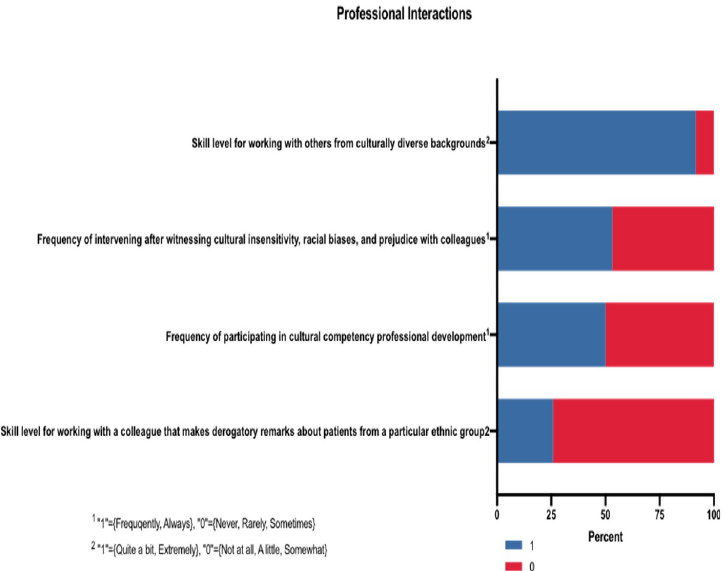
Fig 3. Professional interactions results. 1 “1” = {Frequently, Always}, “0” = {Never, Rarely, Sometimes}. 2 “1” = {Quite a bit, Extremely}, “0” = {Not at all, A little, Somewhat}.